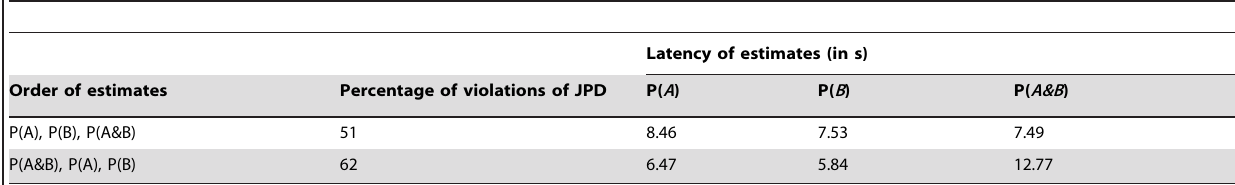
Table 3. The two different orders of estimates in Experiment 1, the percentage of participants’ violations of the JPD, and the latencies (in s) of participants’ estimates of the three different probabilities.